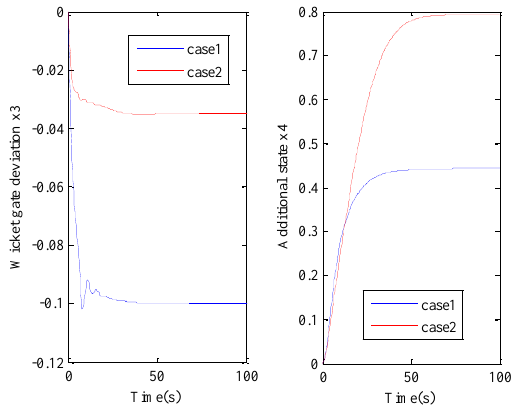
Figure 6(b). Water gate deviation x 3 and additional state x